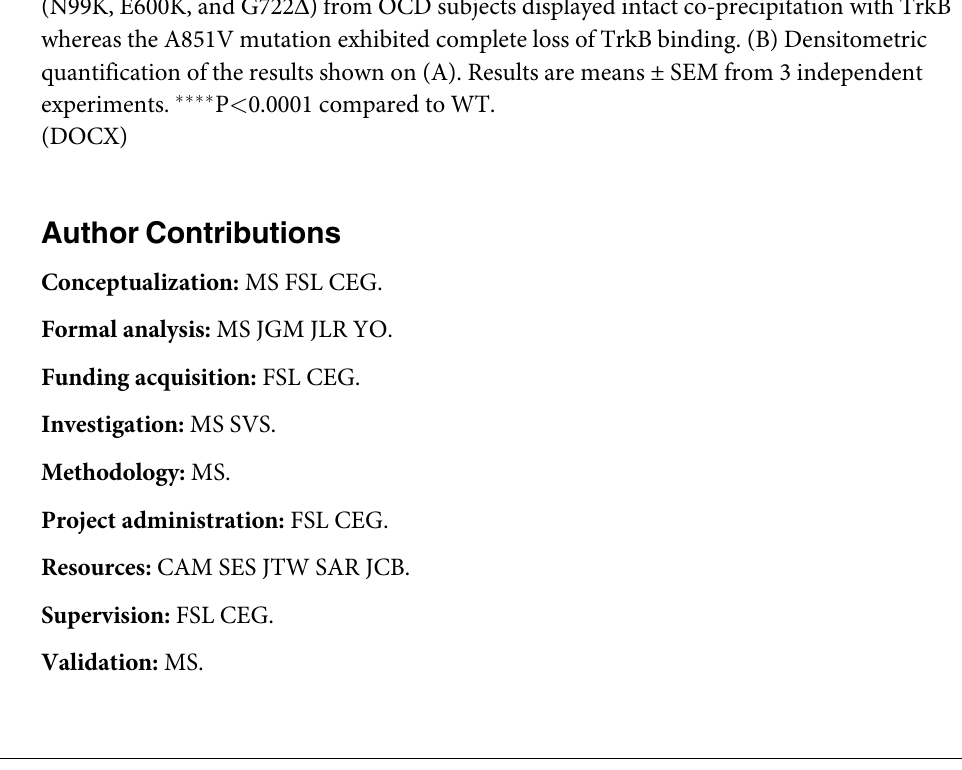
S1 Fig. TrkB binding is intact in most of OCD-associated SLITRK5 mutations. (A) Repre- sentative blots showing co-immunoprecipitation of TrkB to Slitrk5 alleles. Three mutations (N99K, E600K, and G722 Δ ) from OCD subjects displayed intact co-precipitation with TrkB whereas the A851V mutation exhibited complete loss of TrkB binding. (B) Densitometric quantification of the results shown on (A). Results are means ± SEM from 3 independent experiments. (cid:3)(cid:3)(cid:3)(cid:3) P < 0.0001 compared to